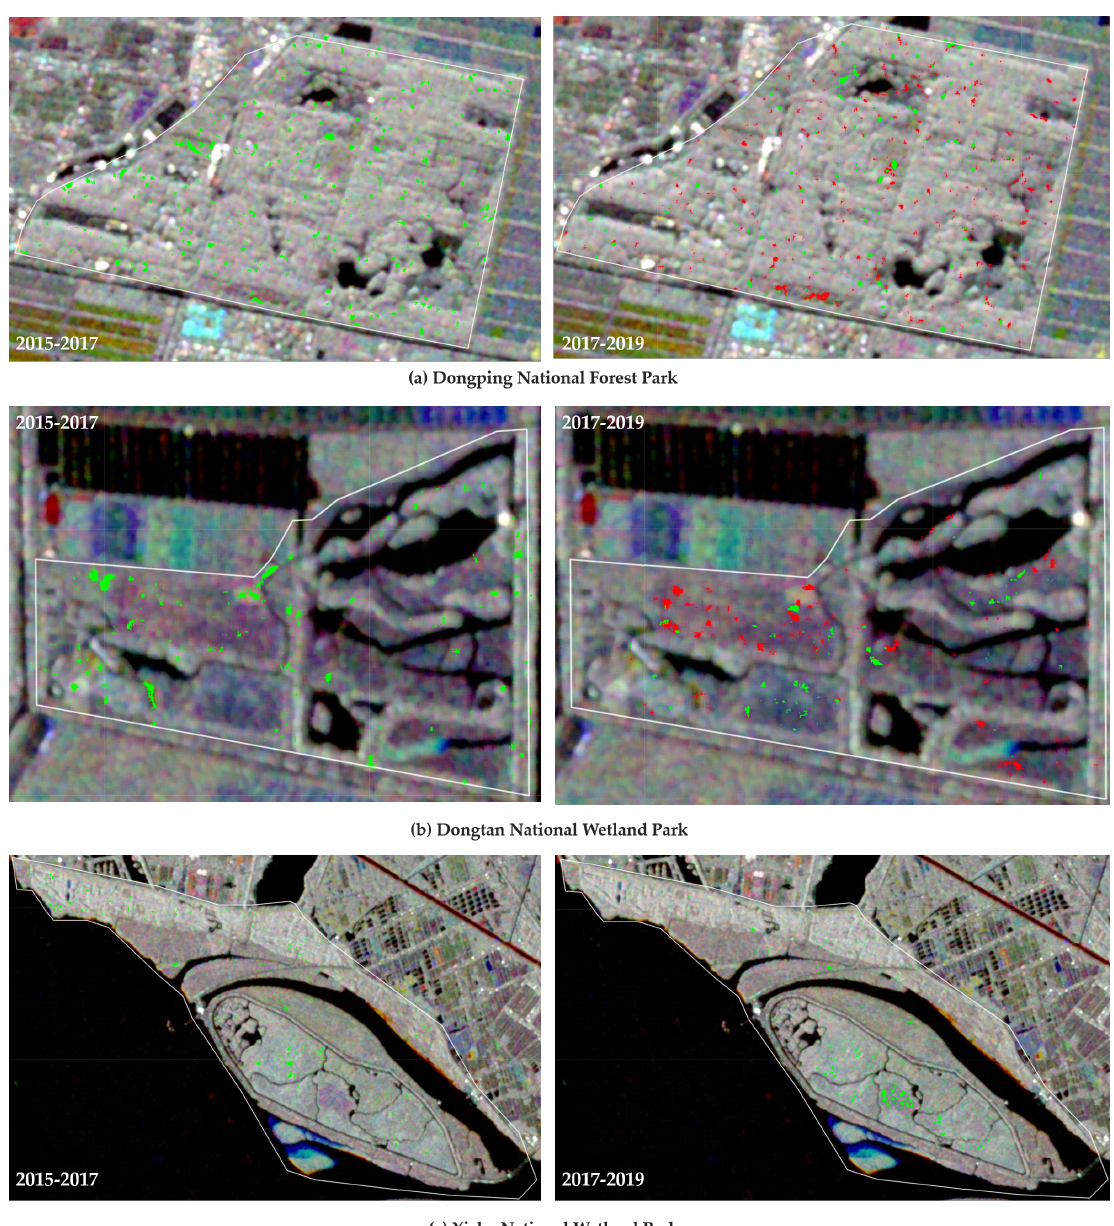
Figure 11. This figure shows the area of the forest change over three strictly portered forest regions from 2015 to 2019. The three famous forest parks are highlighted with polygonal white edges. Regions in the green mask indicate the increase of forest area. Regions in the red mask indicate the decrease of forest